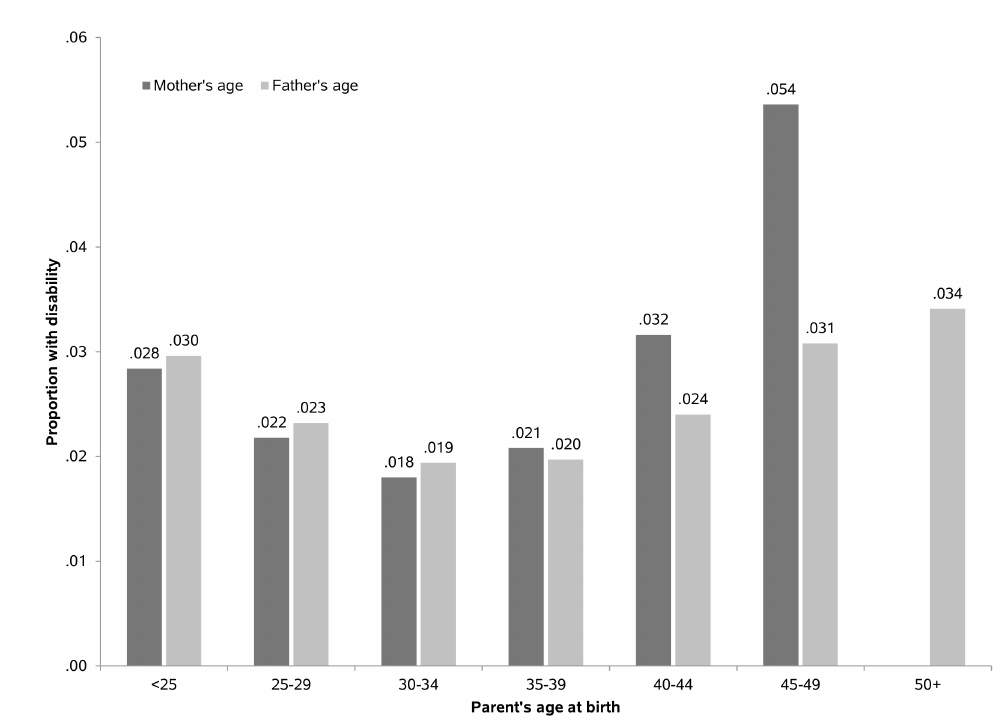
Figure 1: Proportion of children with cognitive disabilities, by mother’s and father’s age at